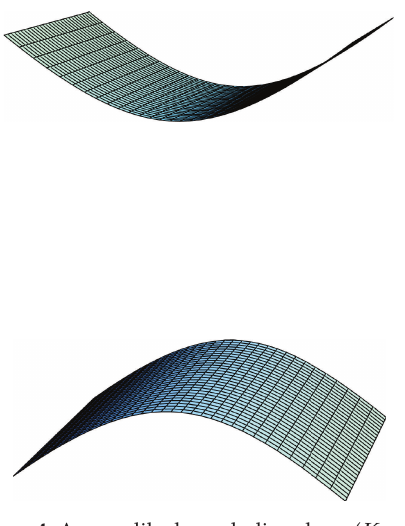
Figure 4: A spacelike hyperbolic sphere (cid:3) K (cid:7) 0 (cid:4)